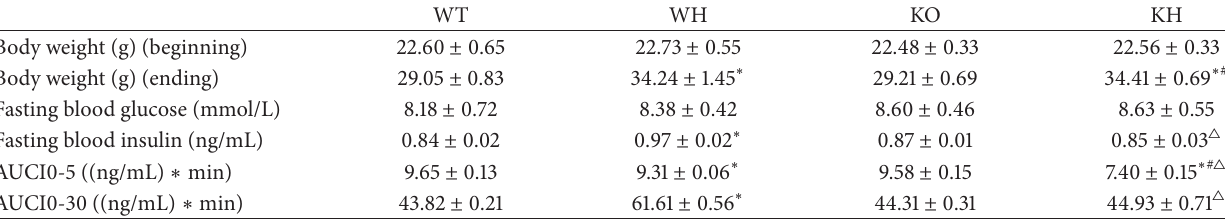
Table 1: Body weight, blood glucose, blood insulin, and islet function (mean ± SD). WT WH